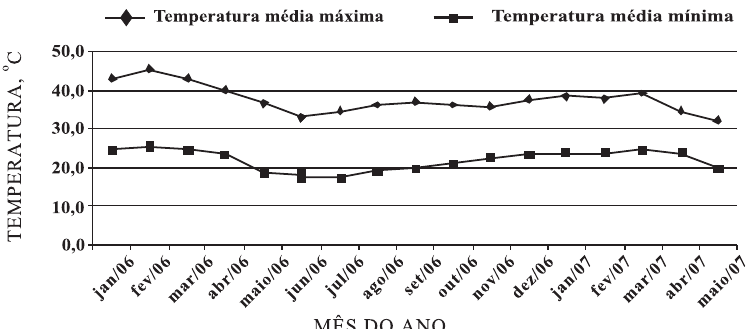
Figura 1. Temperaturas máximas e mínimas (médias mensais) obtidas no interior da casa de vegetação. Campos dos Goytacazes,